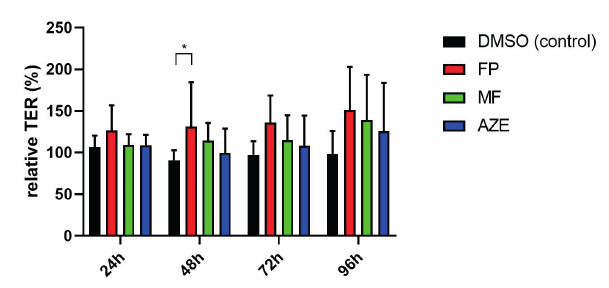
Figure 1. Each bar represents the effect of the added substance as the relative change in TER (%) compare to T0 (baseline before addition of component). Whiskers show standard deviation. FP shows a significant increase of the TER after 48h (p = 0.04). n=53 ALIs.